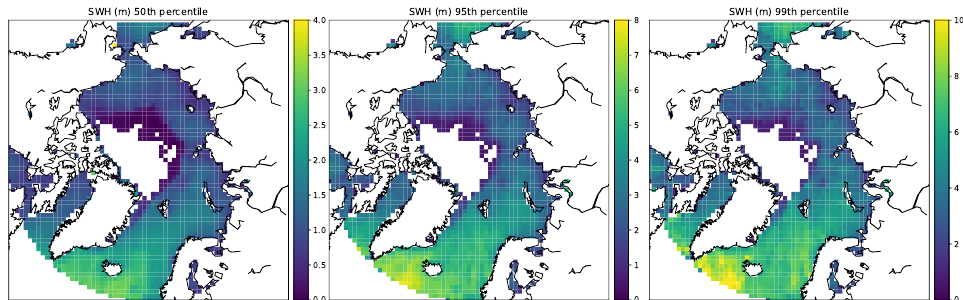
Figure 11. The 50th, 95th and 99th percentile of SWH for the entire period